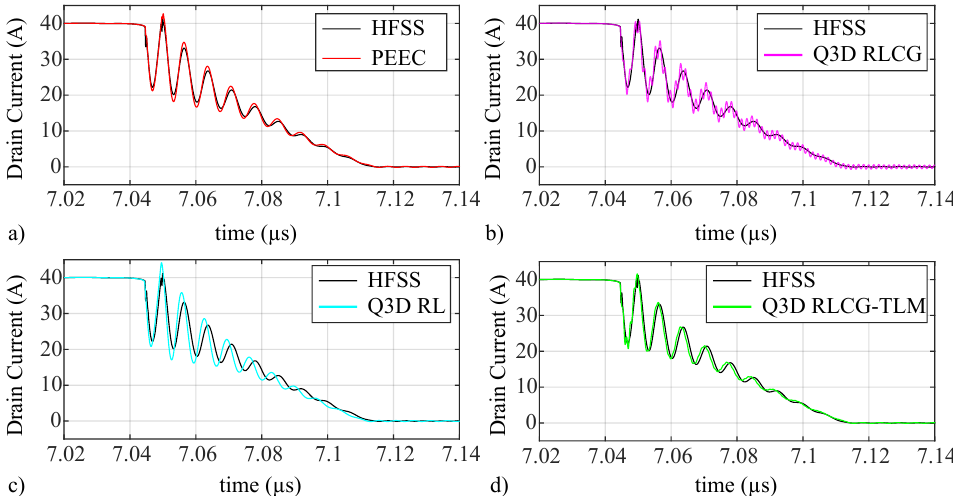
Figure 5. Simulations of HF oscillations observed in the drain current waveform of a fast switching Si SJ power MOSFET M DUT1 for I L = 40 A, V test = 400 V, R gate = 2 Ω , C gd,ext = 10 pF using the extracted S 6 × 6 parameters: ( a ) HFSS vs. PEEC, ( b ) HFSS vs. Q3D RLCG, ( c ) HFSS vs. Q3D RL, and ( d ) HFSS vs. Q3D RLCG-TLM.